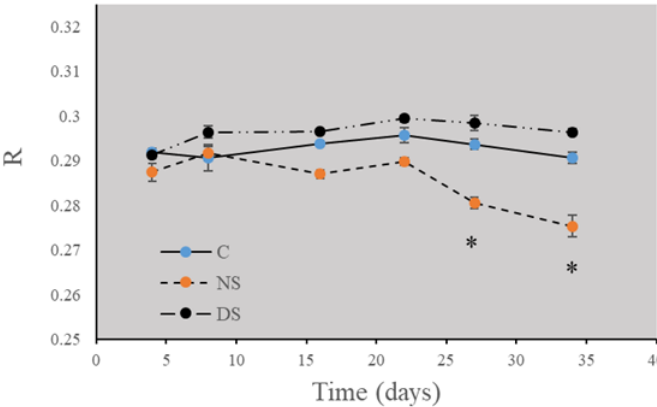
Figure 3. Reflectance index (R) of petunia plants measured on different days after exposure to optimal (C), nitrogen stress (NS) and drought stress (DS) treatments in the main experiment. The R-value was measured based on images of petunia plants captured inside a multi-spectral image station. A. *denotes statistical significance ( p ≤ 0.05) between NS and C treatments on a given day.